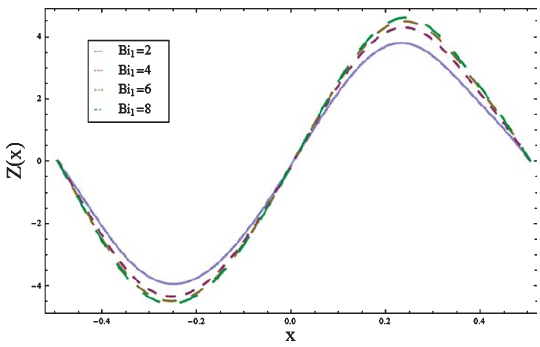
Fig. 13. Plot showing Z ( x ) versus x . Here a = 0 . 3, b = 0 . 5, d = 1, φ = π/ 4, (cid:14) = 1 . 5, Br = 2, Bi = 10, n = 0 . 398 and We = 0 . 1. 2